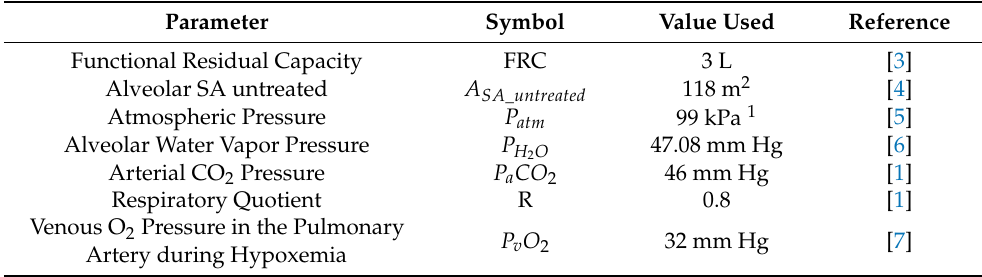
1 Atmospheric Pressure is calculated from a 194 m elevation and using the relationship P atm = 101325 ( 1 − 0.0000225577 ∗ Elevation ) 5.2588